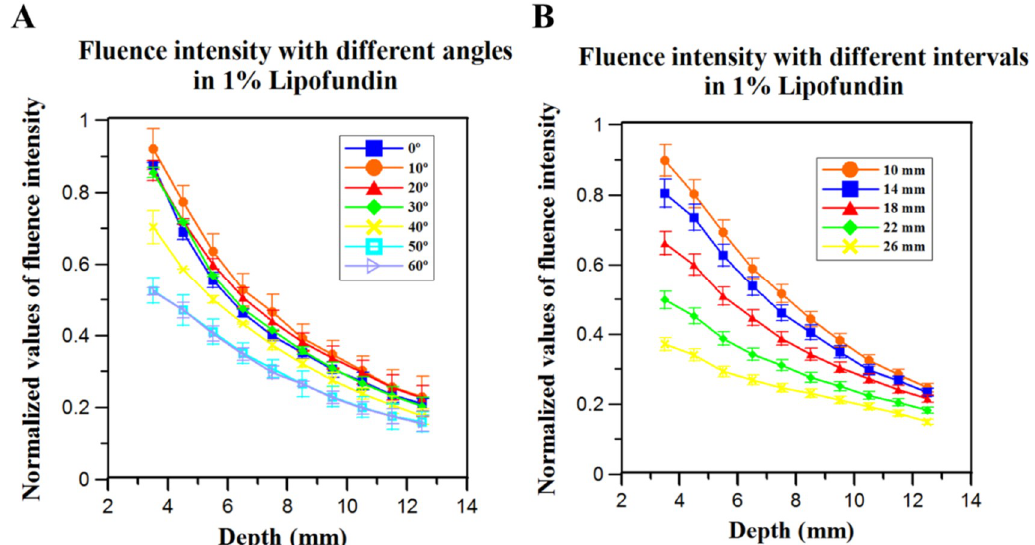
Figure 5. Evaluation of the fluence intensity change in 1% Lipofundin at different depths. ( A ) The angle changed from 0 degree to 60 degrees, while the interval between the two output arms was fixed at 14 mm. ( B ) The interval ranged from 10 mm to 26 mm, while the angle was fixed at 35 degrees for the fluence evaluation. According to ( A ) and ( B ), the angles of the fiber bundle would not largely affect the fluence intensity, while a shorter interval (separation) of the two arms could greatly influence the intensity in scattering medium. Thus, we designed the interval of the two arms to be as short as possible for the system, while the angle was chosen as 35 degrees for experiments in both water and scattering medium.